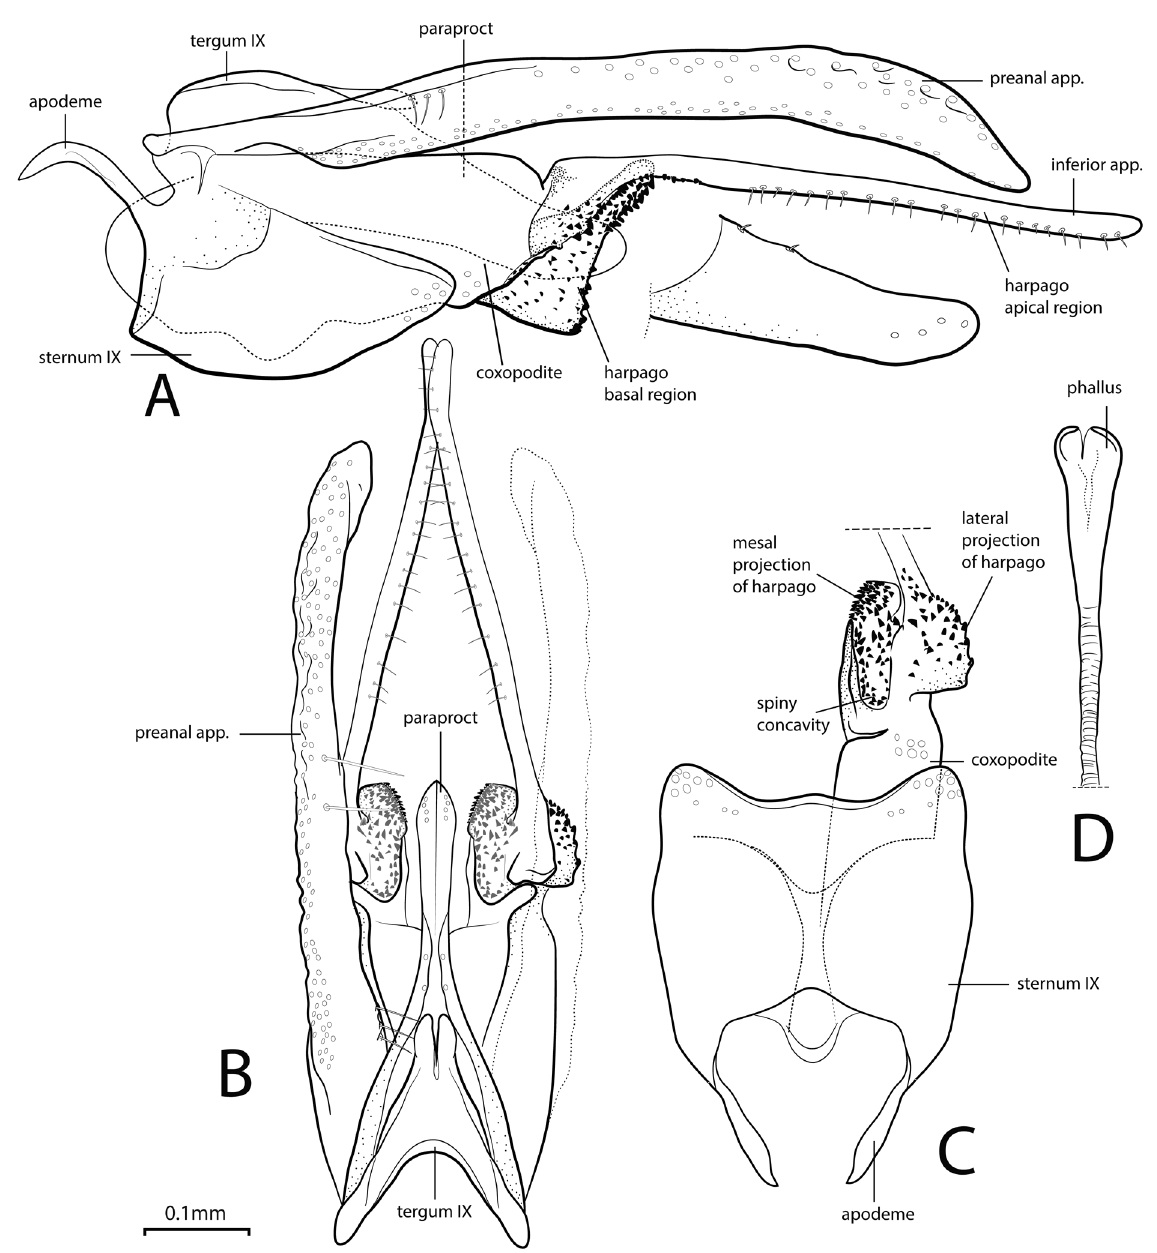
Fig. 4. Machairocentron amahuaca sp. nov., holotype, male genitalia (MUSM-ENT-0320559). A . Lateral view, with detail of paraproct. B . Dorsal view. C . Ventral view. D . Phallus, dorsal